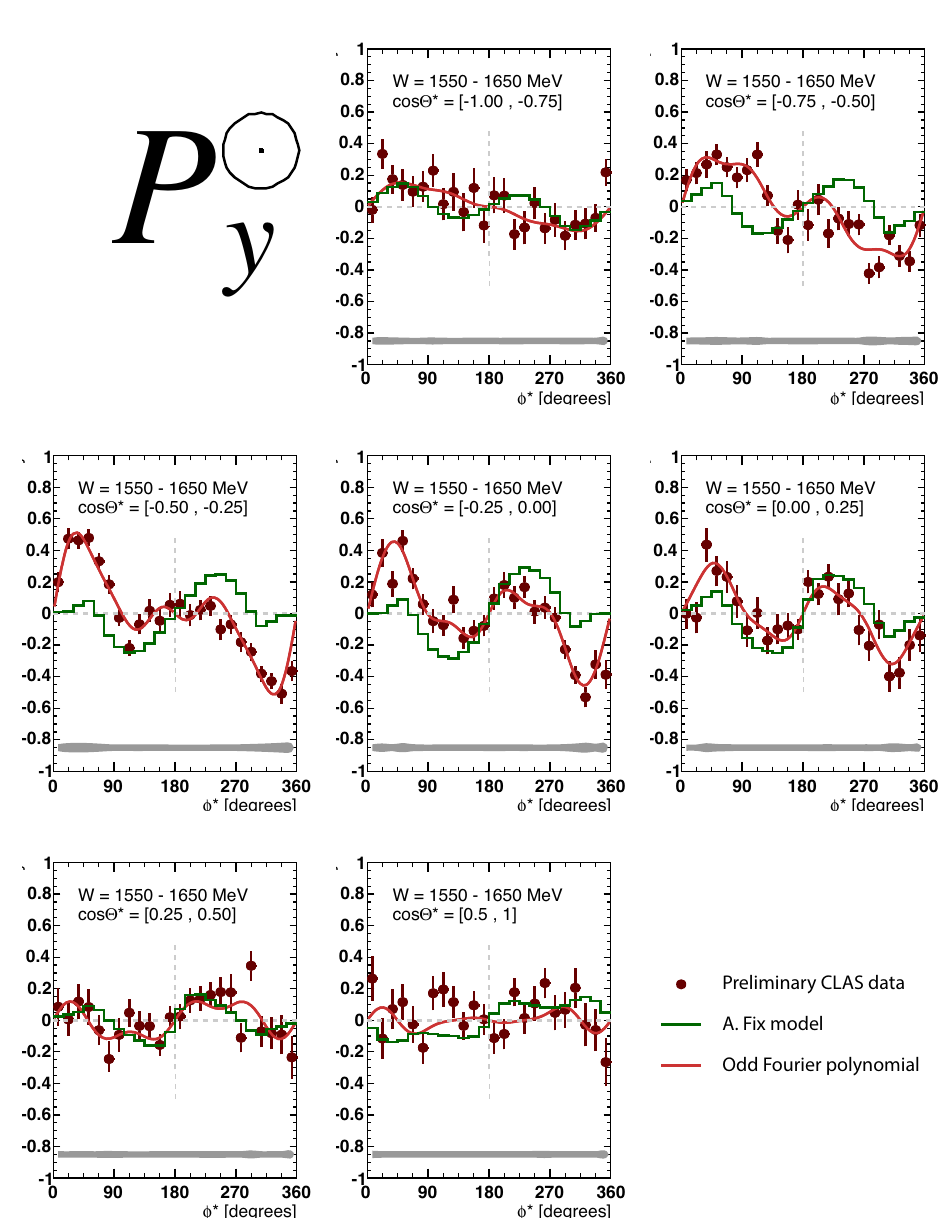
Figure 2. Preliminary Φ ∗ azimuthal angular distributions of the beam-target polarization observable P (cid:6) y for the γ p → π + π − p reaction in the energy range W = 1550 MeV to 1650 MeV [36]. The seven panels correspond to bins in the polar angle Θ ∗ . The solid green histograms are CLAS-acceptance averaged results of model calculations from A. Fix [37]. To guide the eye, the data are also fitted with low-order polynomials in sin Φ ∗ (red curves). The angles Φ ∗ and Θ ∗ are, respectively, the azimuthal and polar angles of the final-state π + ; see Ref. [36] for